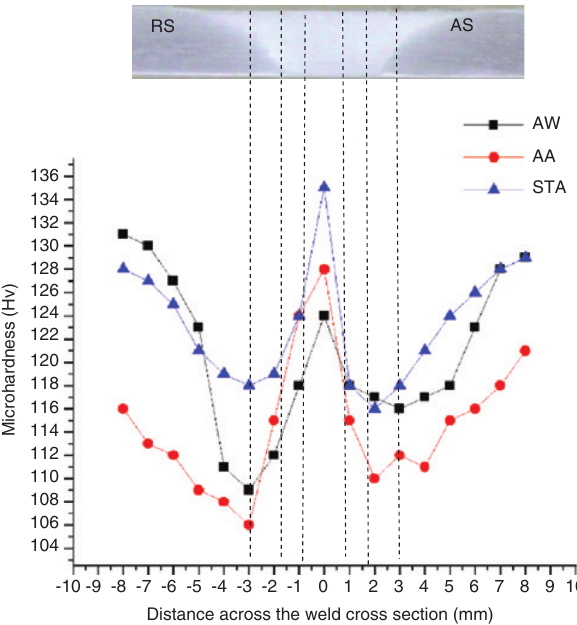
Figure 7: Microhardness profile across the cross section of the weld.